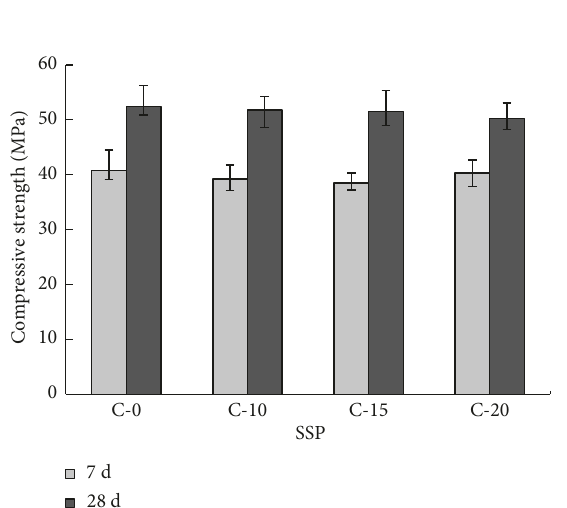
Figure 13: The compressive